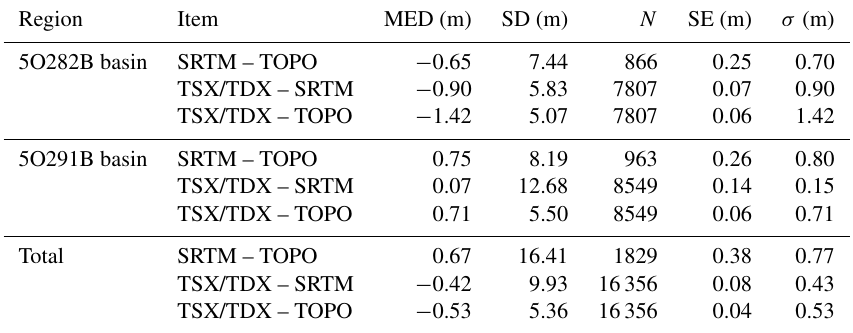
Table 2. Statistics of vertical errors between the TOPO, SRTM and TSX/TDX. MED is mean elevation difference, SD is standard deviation, N is the number of considered pixels, SE is standard error and σ is the overall error of the derived surface elevation change. Region Item MED (m) SD (m) N SE (m) σ (m) 5O282B basin SRTM – TOPO − 0.65 7.44 866 0.25 0.70 TSX/TDX – SRTM − 0.90 5.83 7807 0.07 0.90 TSX/TDX – TOPO − 1.42 5.07 7807 5O291B basin SRTM – TOPO 0.75 TSX/TDX – SRTM 0.07 TSX/TDX – TOPO 0.71 Total SRTM –